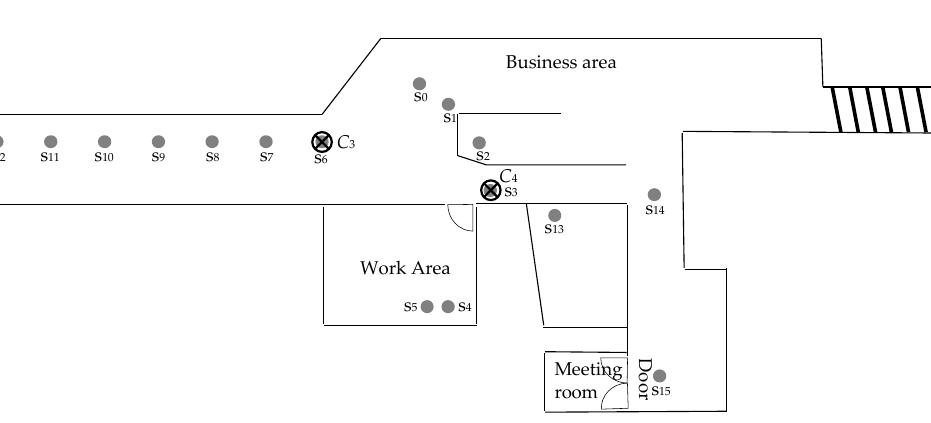
Figure 13. Electromagnetic wave power density for C 2 to S 0 , S 1 , …, and S 15 .